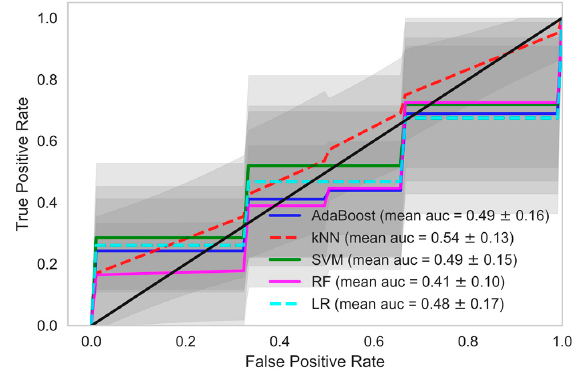
Figure 7. Receiver Operating Characteristics plot showing mean area under curve of all the classifiers of Model 3 when the 15 recent HD sessions were considered.